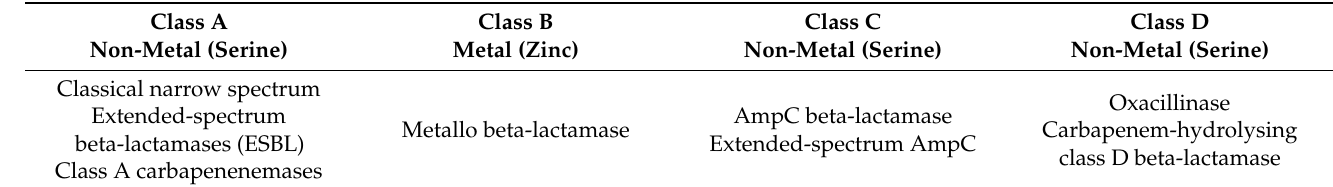
Table 1. Ambler’s classification of beta-lactamases